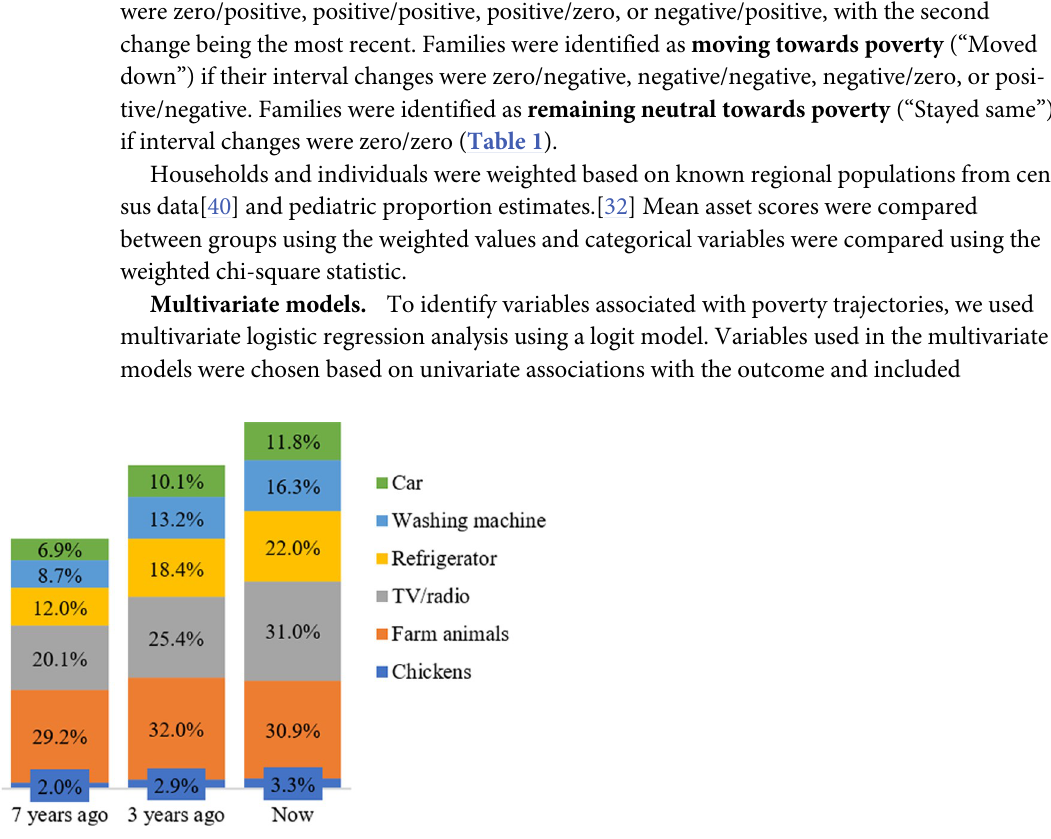
Fig 1. Descriptive status of household assets in